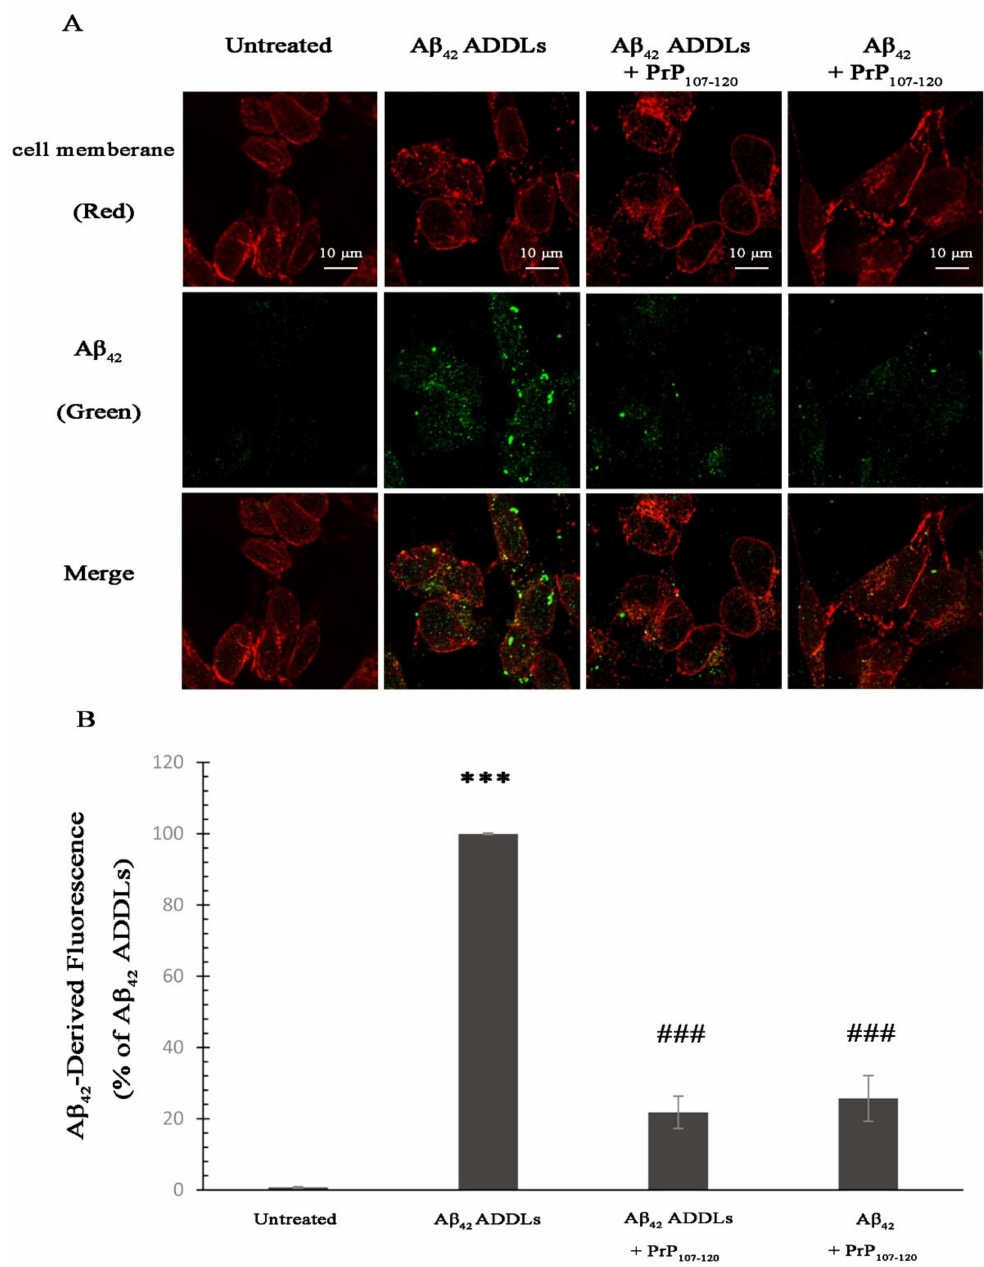
Figure 7. E ff ect of PrP 107–120 on A β 42 ADDL internalization in SH-SY5Y cells. ( A ) Representative scanning confocal microscopy images of SH-SY5Y cells treated with the indicated samples and showing A β 42 ADDLs. The cells were treated with the same samples described in the Figure 4 legend. The cellular membrane was stained with wheat germ agglutinin (red fluorescence) and A β 42 ADDLs were labelled with mouse monoclonal primary antibody 6E10 and anti-mouse secondary antibody (green fluorescence). Scale bar = 10 µ m. ( B ) Semi-quantitative analysis of intracellular A β 42 ADDL-derived fluorescence. Experimental errors are S.E.M. ( n = 3). The triple (***) asterisks refer to p values < 0.001 relative to the untreated cells. The triple (###) symbols refer to p values < 0.001 relative to A β 42